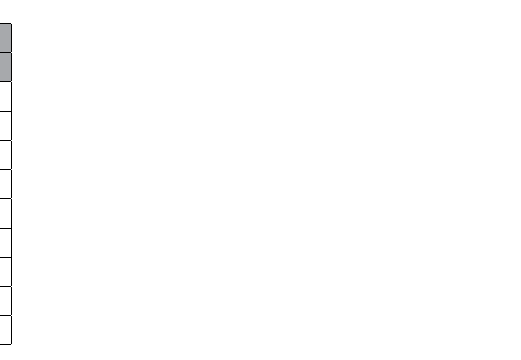
Table 6. Kinetic parameters of DPPH radical-scavenging activity of O. gratissimum extracted with different solvents at different temperatures as a function of exposure time. r 2 regression coefficient, K 0 rate constant for zero-order reaction, K 1 rate constant for first-order reaction, K 2 rate constant for second-order reaction.